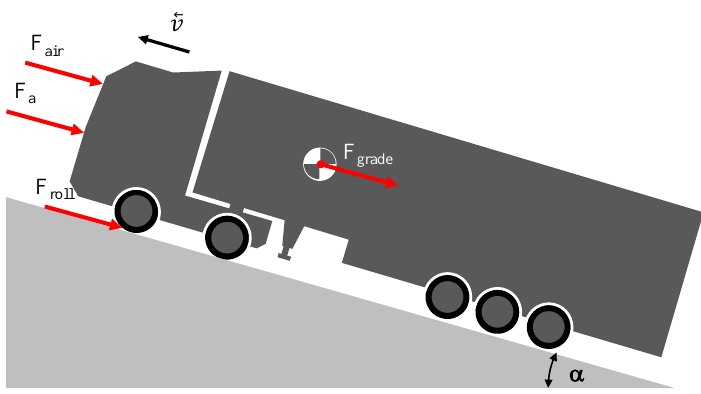
Figure 4. Driving resistances acting at the truck.